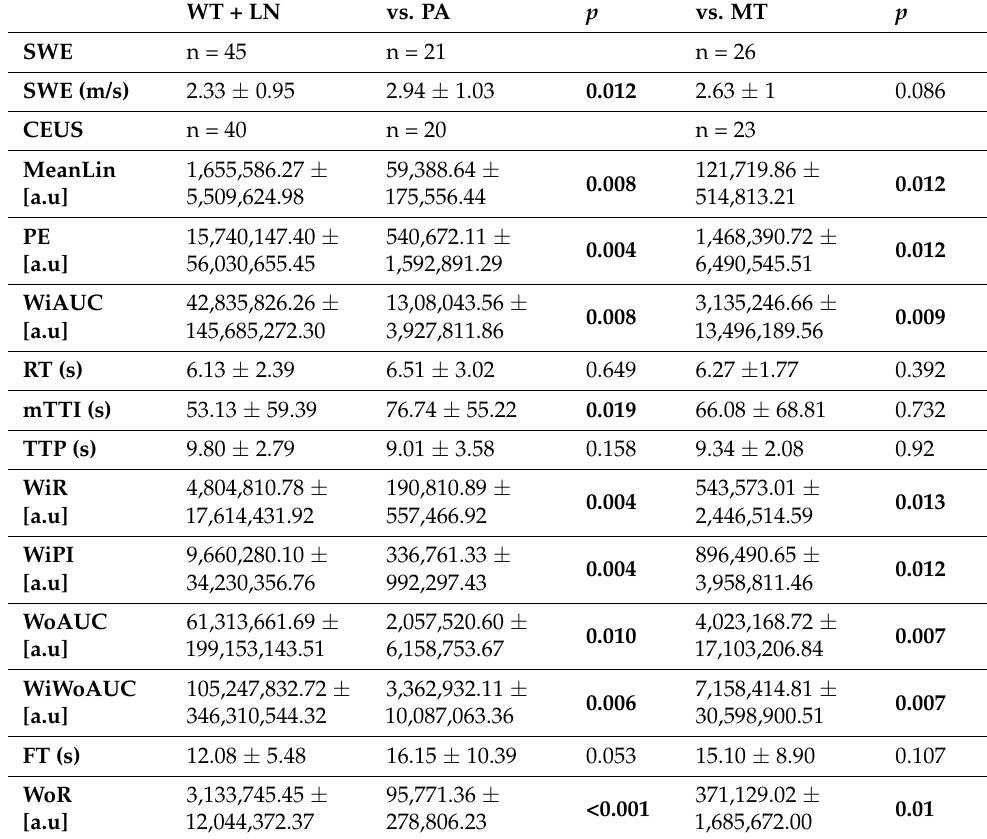
Table 4. Results of Warthin’s tumors paired with lymph nodes compared to different entities. All met- ric variables are given as the median with corresponding standard deviation; significant p -values are pointed out in bold. Abbreviations: SWE denotes shear wave elastography; CEUS—contrast